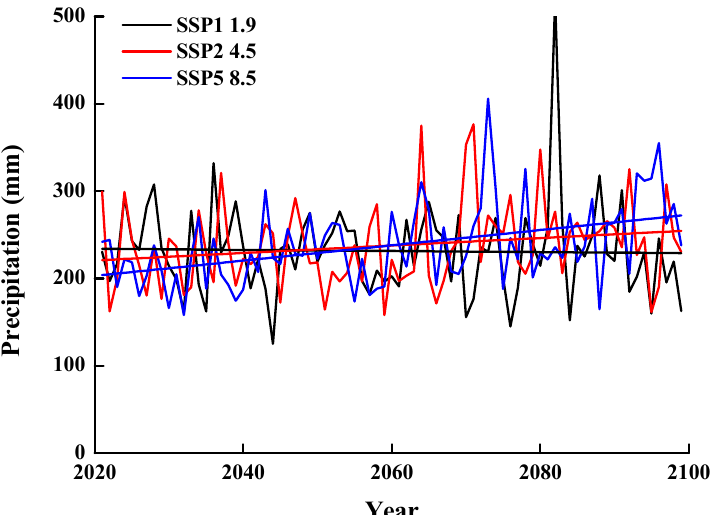
Figure 2. Projected annual precipitation in SSP1 1.9, SSP2 4.5, and SSP5 8.5 scenarios from 2021 to 2099, using data from the Fukang weather station.